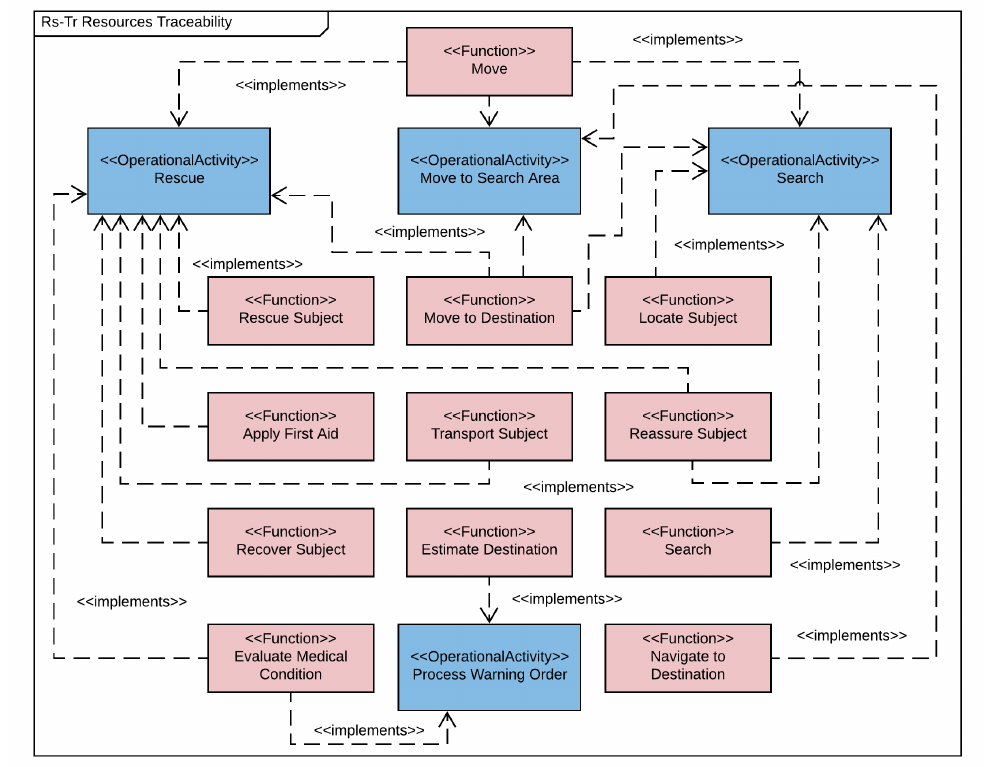
Figure 10. An example of a Resource Traceability (Rs-Tr) view of the UAF that describes the connec- tion between operational activities and functions that implement